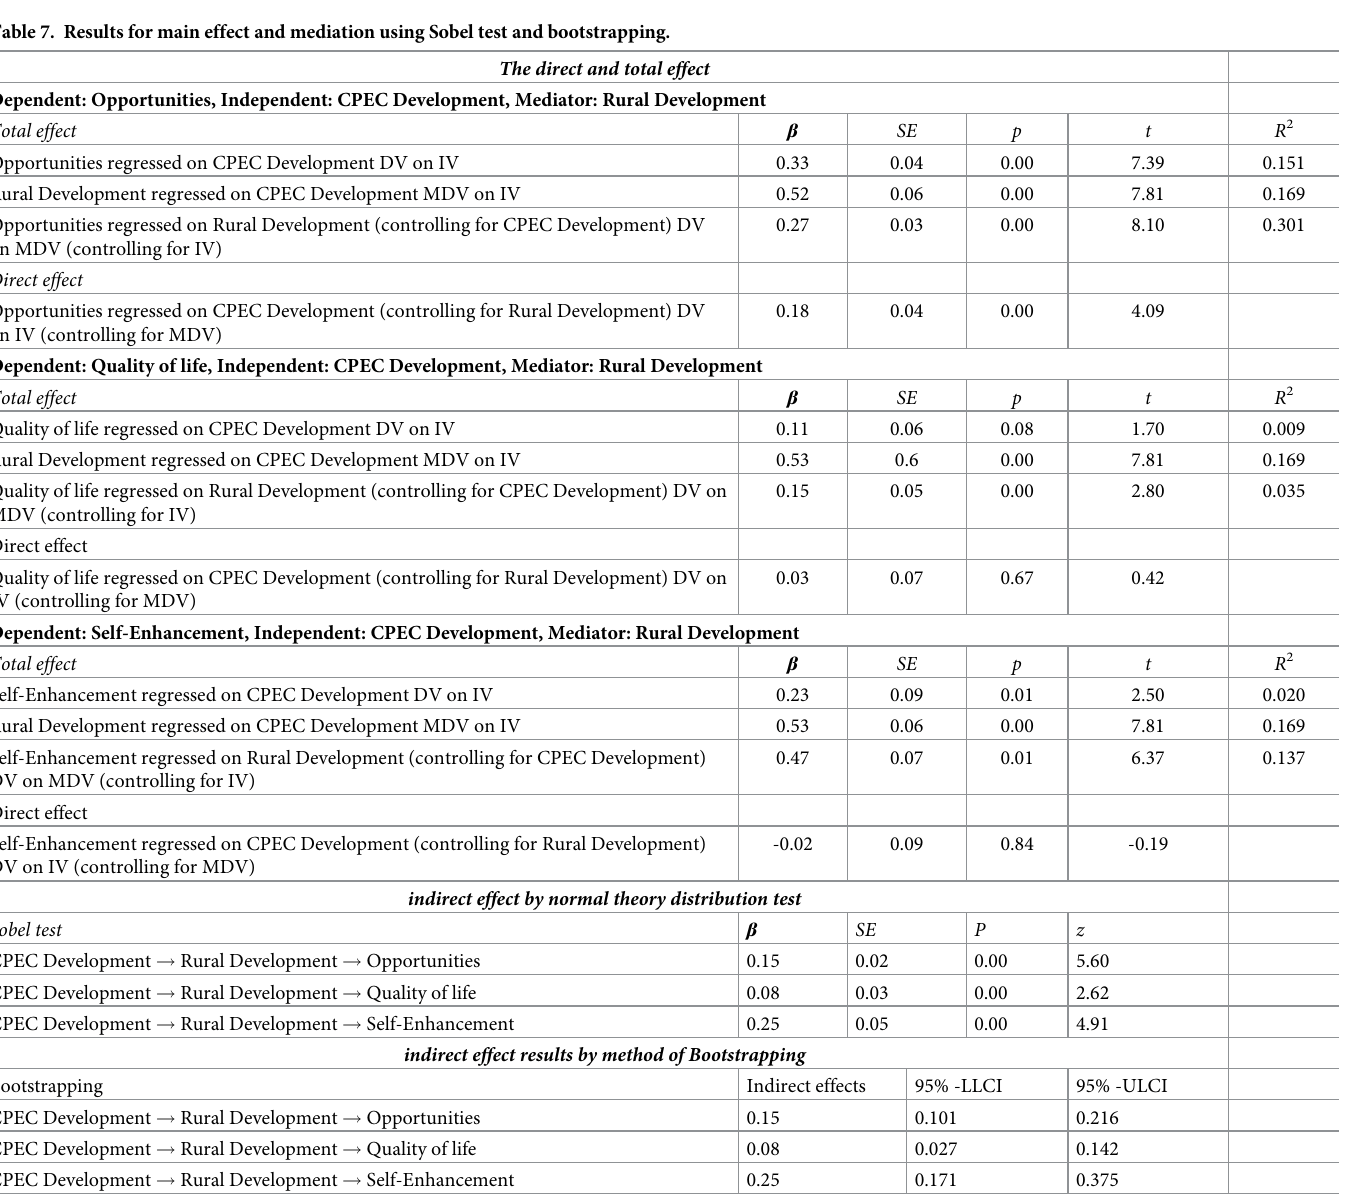
Table 7. Results for main effect and mediation using Sobel test and